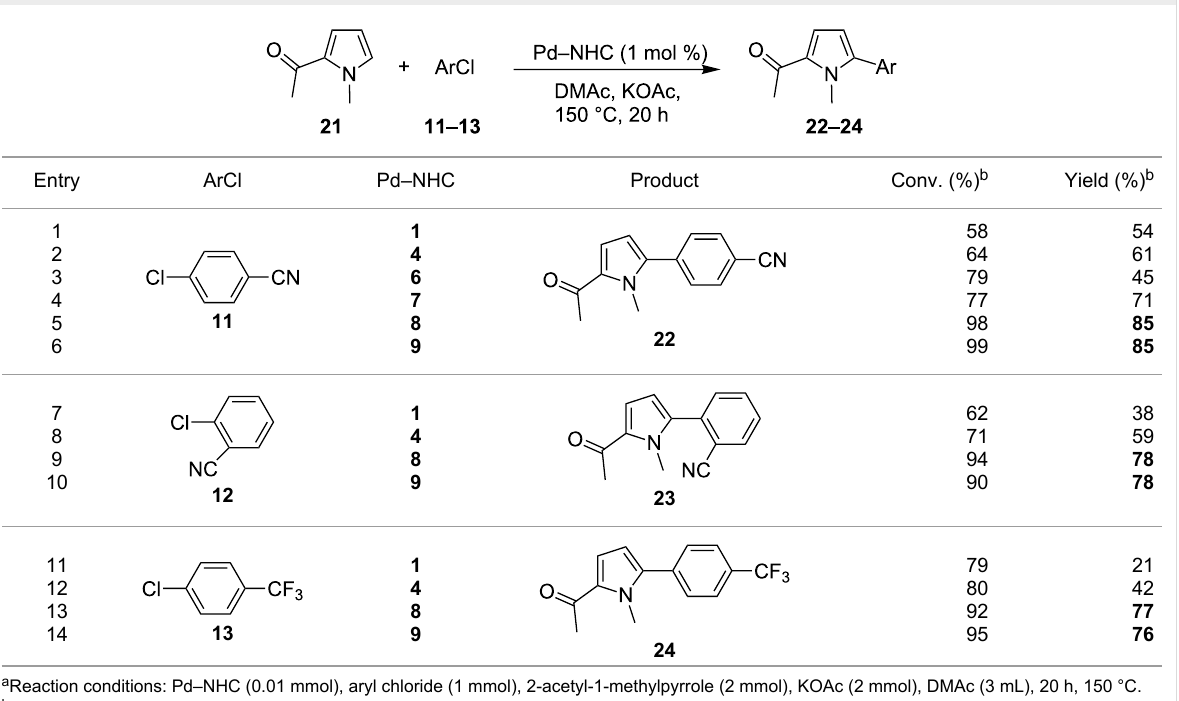
Table 2: Direct arylation of 2-acetyl-1-methylpyrrole ( 21 ) with chlorobenzene derivatives. a